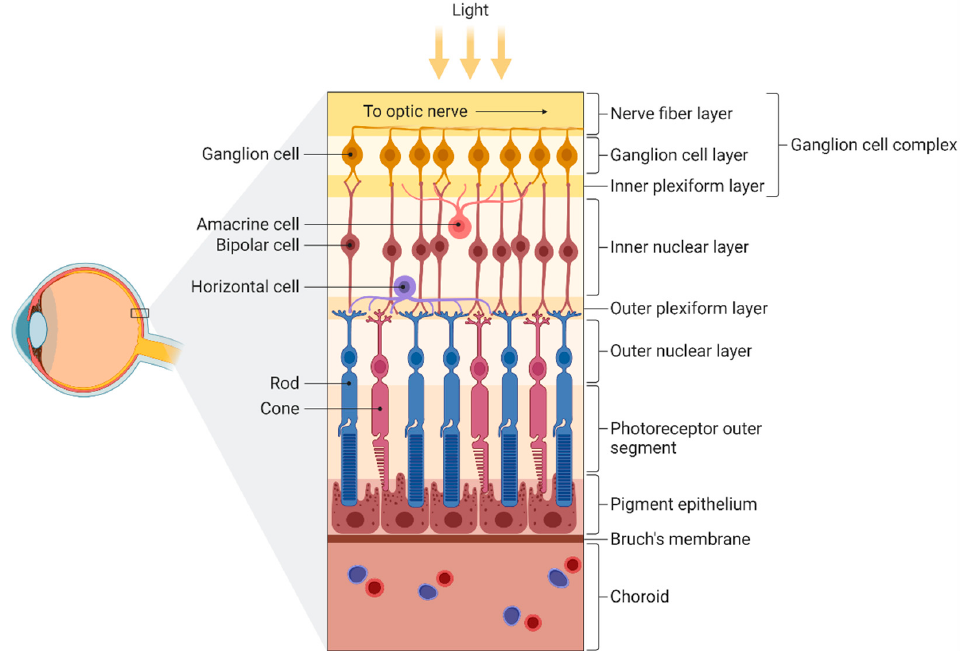
Figure 2. Schematic illustration of the different layers of the retina. From inner to outer: nerve fiber layer (containing axons from ganglion cells), ganglion cell layer (containing ganglion cells), inner plexiform layer (containing dendrites from ganglion, bipolar, and amacrine cells), inner nuclear layer (containing bipolar and amacrine cells), outer plexiform layer (containing extensions from horizontal cells and both rods and cones), outer nuclear layer (containing somas of both rods and cones), photoreceptor outer segment, pigment epithelium, Bruch’s membrane, and choroid. Figure created by BioRender.com software (Toronto, ON, Canada).